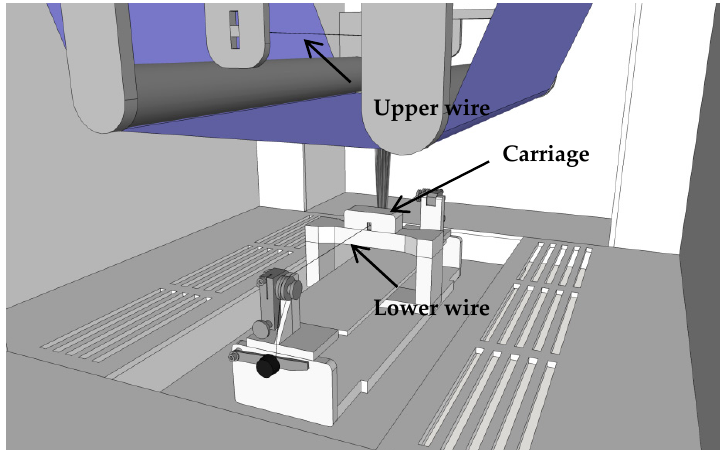
Figure 1. Sketch of the Nanospider. The carriage containing the spinning solution coats the lower electrode wire through a spinning nozzle. A high electric field drags the polymer coating to the upper electrode, in this way elongating and thinning the polymer droplets until they become nanofibers and are finally stopped on the substrate (blue).